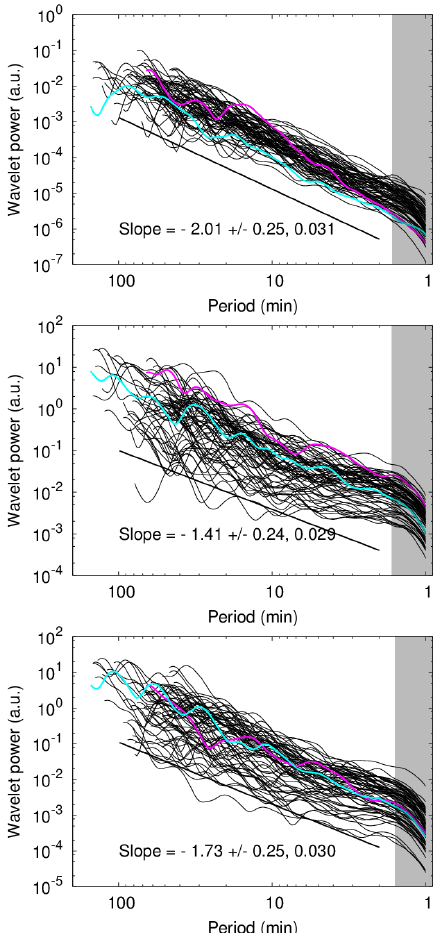
Fig. 7. Global wavelet spectra (GWS) for z c (t) (top), β peak (t) (middle) and β int (t) (bottom). Sixty-seven (67) time series longer than 2h were analyzed (238h, NWT and SET). The two exam- ples discussed in more detail in this paper are shown in color (19 July 2011 in pink, 25 July 2010 in light blue).